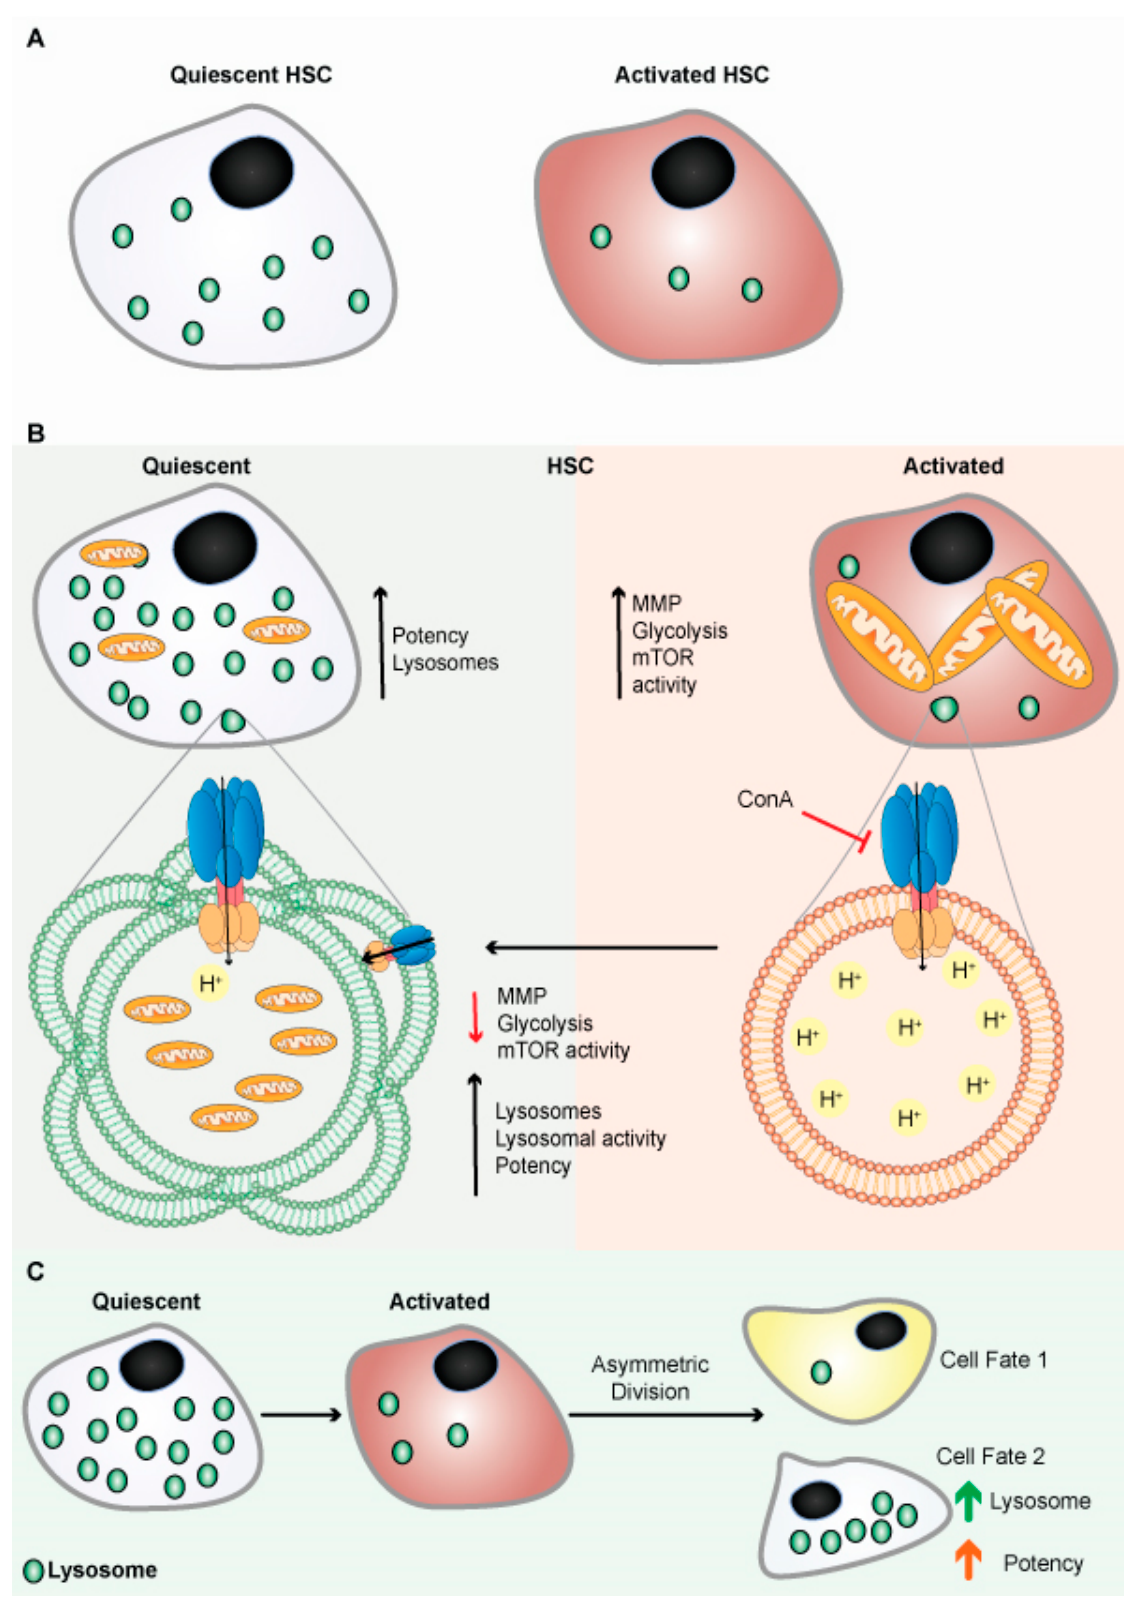
Figure 4. Lysosomes are abundant in quiescent HSCs. ( A ) Schematic representation shows quiescent HSCs are abundant in lysosomes. ( B ) Schematic representation shows quiescent HSCs are abundant in lysosomes and have poor mitochondrial lysosomal clearance. HSCs are primed by acidification